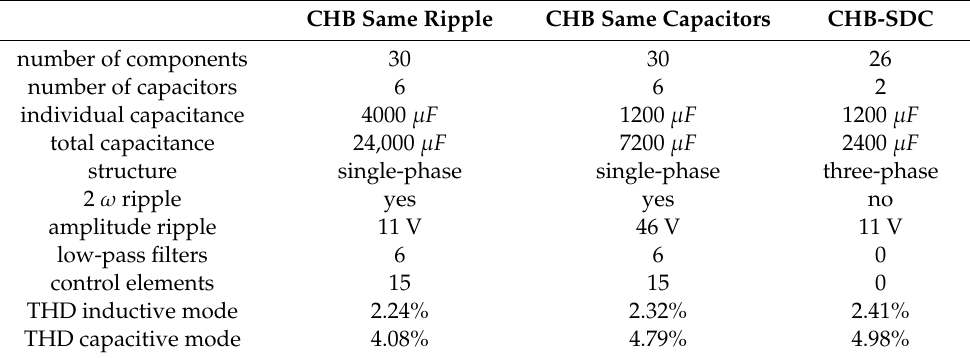
Table 4. Comparison between five voltage levels